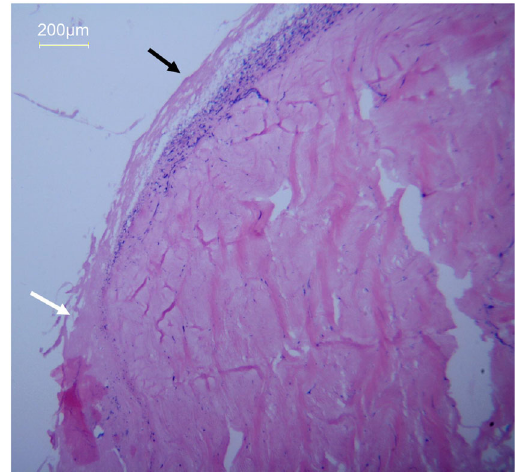
Fig. 1 Hematoxylin and eosin (H&E) staining of the rabbit Achilles tendon treated with hypotonic Tris buffer without chemical detergents. Major nuclear components accumulated under the intact aponeurosis (black arrow), and a small amount of residual nuclear components were visible at the edge of the incomplete aponeurosis (white arrow) (magni fi cation ×100)